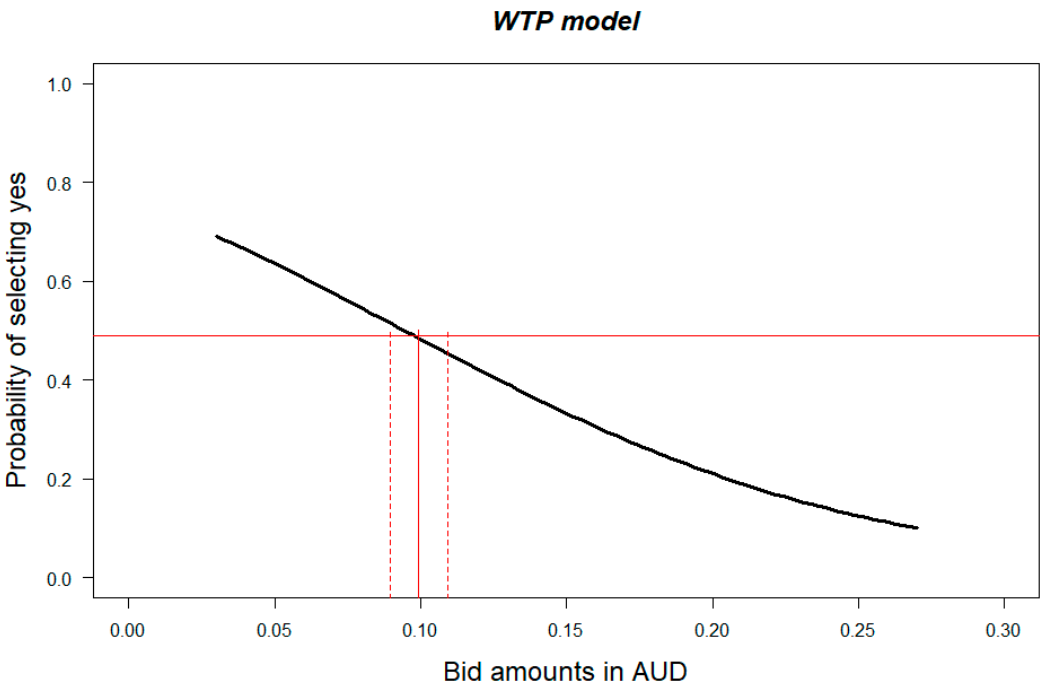
Figure 3. Price premium estimates in Australian dollars (AUD) for a box of cookies with the Health Star Rating on the front of the pack, where a box without the Health Star Rating costs AUD 3.00. Table 3. Consumers’ willingness to pay estimates and confidence intervals in Australian dollars (AUD) for a box of cookies with the Health Star Rating on the front of the pack, where a box without the Health Star Rating costs AUD